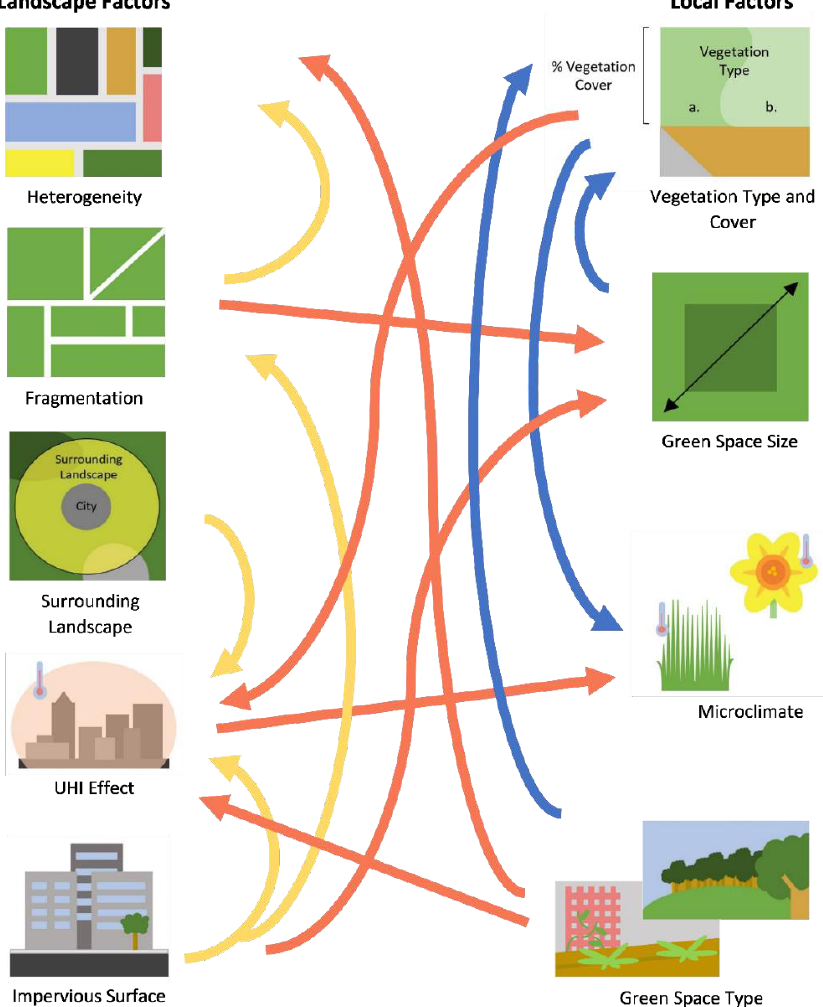
Figure 1. Diagram displaying some of the interactions between landscape and local features. Arrows represent features affected by other features from which the arrow originates. Local–local (blue), landscape–local (red), and landscape–landscape (yellow) interactions are